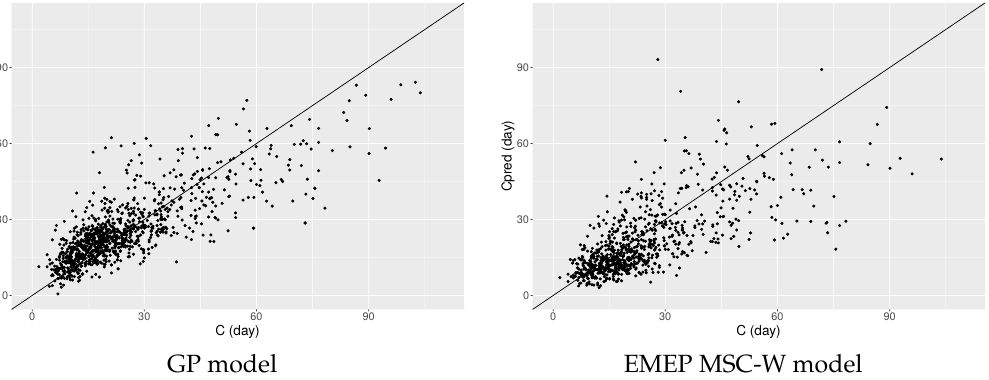
Figure 11. Observed PM 10 levels from Ljubljana against predicted PM 10 levels (GP and EMEP MSC-W models) for tomorrow. Results from the same models as discussed